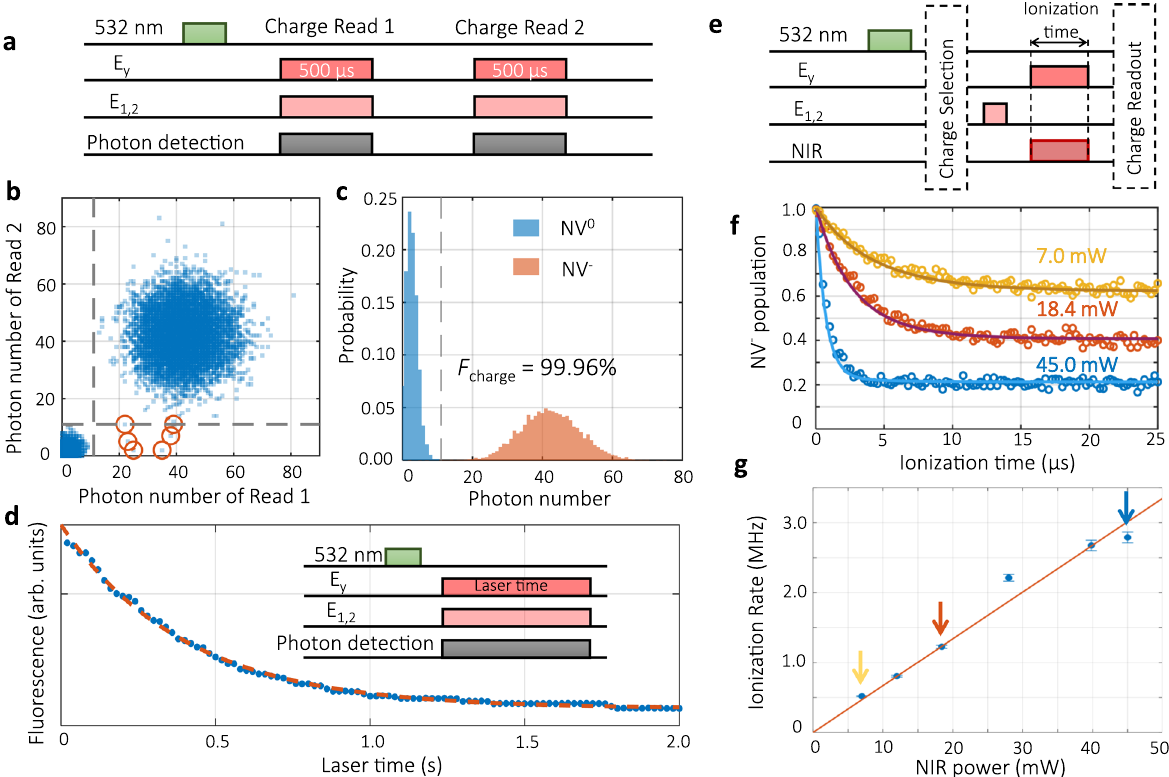
Fig. 2 Non-demolition readout of charge state and ionization rate of NIR light. a Pulse sequence for the charge readout fi delity evaluation. A 3 μ s pulse of 532 nm laser reset the population of NV − to be 78%, according the results in ( b ) and ( c ). Both of the two charge readings use an integration window of 500 μ s. b The correlation between the two consecutive charge readouts. A total of 10,000 tests are performed. Among them there are 7771 cases of (NV − , NV − ), 6 cases of (NV − , NV 0 ), 2223 cases of (NV 0 , NV 0 ), and 0 cases of (NV 0 , NV − ). The orange circles mark the cases with anti-correlation. The charge state is judged to be NV 0 when the collected photon number ≤ 11. The dashed gray lines mark the threshold (the same for c ). c The photon number distribution of NV 0 and NV − . The charge readout fi delity F charge = 99.96%. d The lifetime of the charge state of NV − under E y + E 1,2 (6 + 5 nW) illumination, 400.7 ± 9.7 ms. e Pulse sequence for measuring the ionization rate under simultaneous illumination of E y and NIR light. f The ionization curves of NV − at different powers of 1064 nm. The solid lines are simulations based on different ionization rates. g The dependence of the NIR ionization rate on its power. The solid line is a linear fi t to the data points, with a coef fi cient of 67.0 ± 6.7 kHz/mW. The three arrows correspond to the three ionization curves shown in ( f